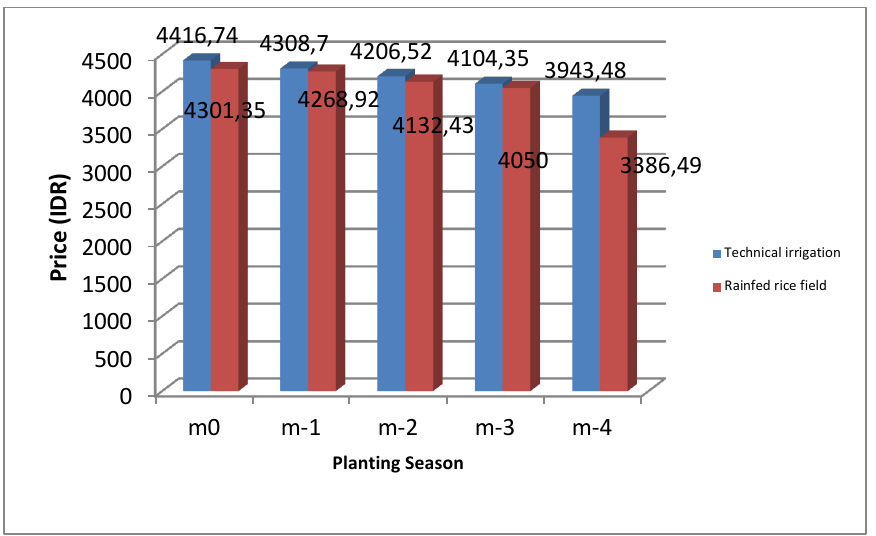
Figure 2: The price of rice received by farmers during the rainy season for the last 5 seasons on technical irrigated rice field and rainfed rice field (IDR/kg)